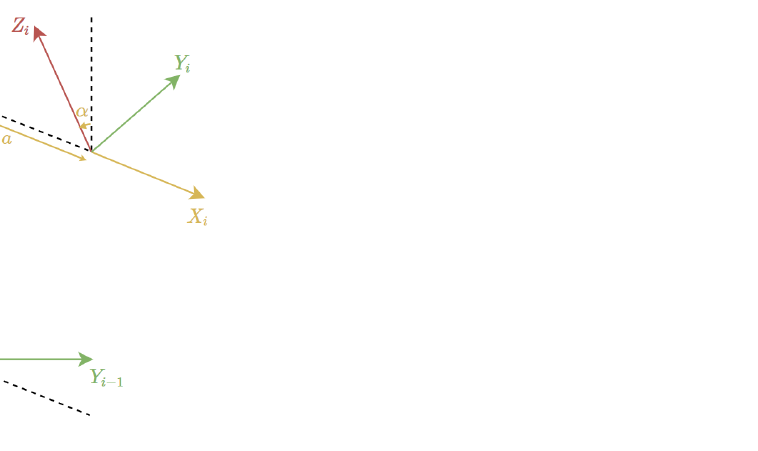
Figure 1. Example of a coordinate transformation with Denavit–Hartenberg (DH)